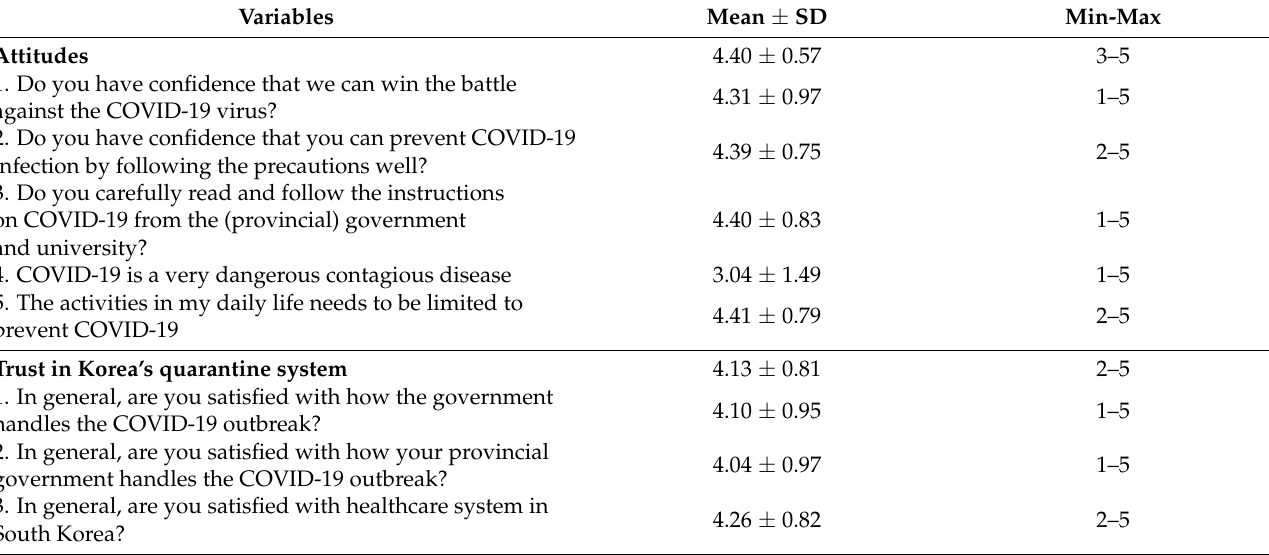
Table 3. Attitudes, trust in Korea’s quarantine system, and preventive practice related to COVID-19 ( N =